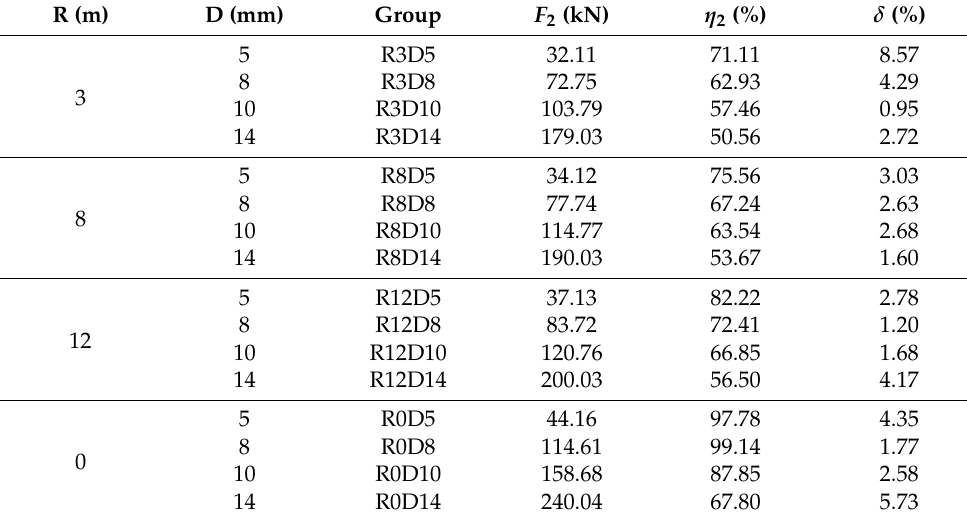
Table 4. Results of FE